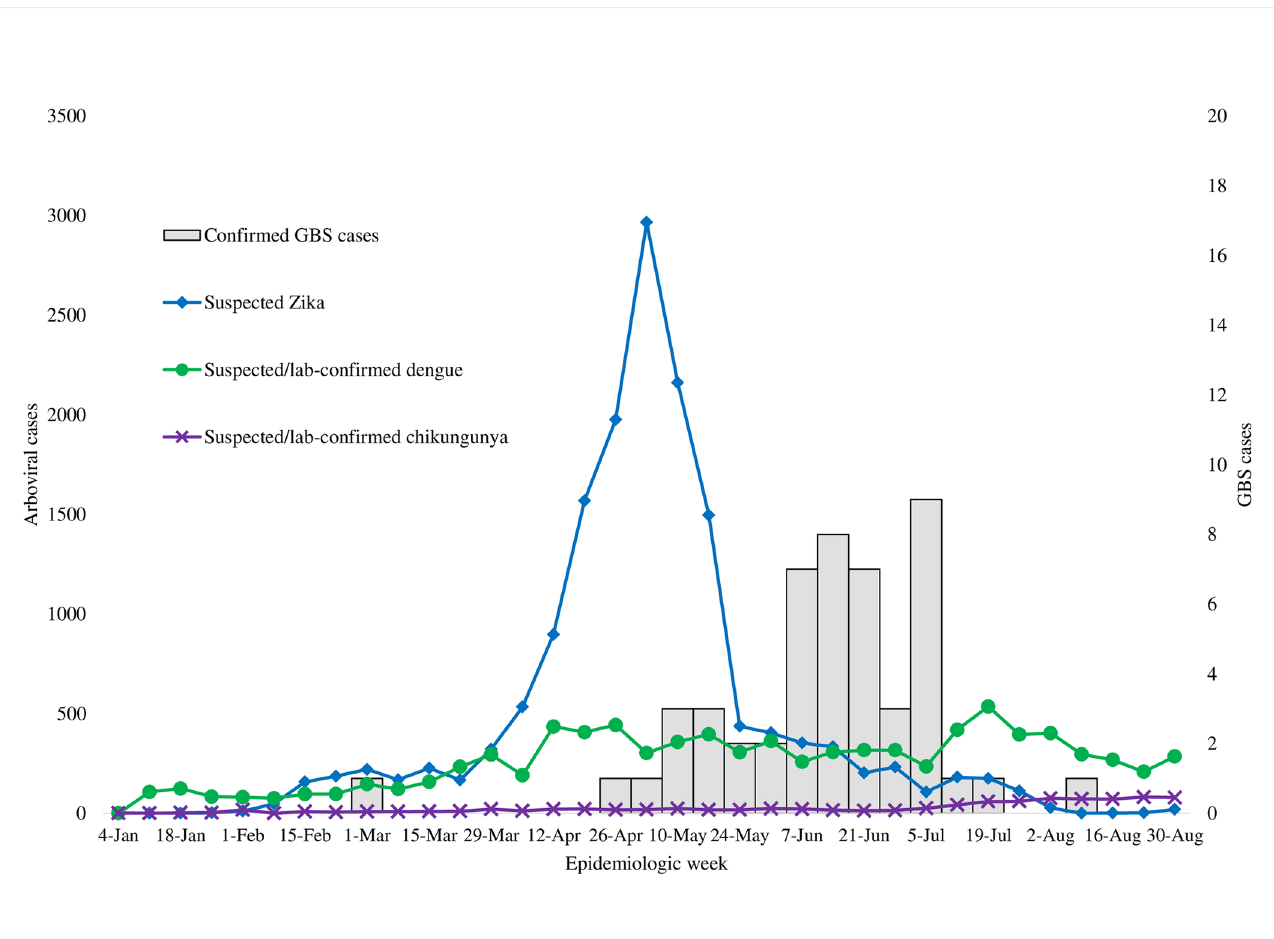
Fig 1. Confirmed GBS and reported Zika, dengue, and chikungunya Cases–Salvador metropolitan area, Brazil 2015. Epidemiologic curve of incident Guillain-Barre´ syndrome(GBS) cases was juxtaposedwith reportedsymptomatic ZIKV, dengue, and chikungunya infectionsin the Salvador metropolitanarea, Brazil, during January1–August 31,